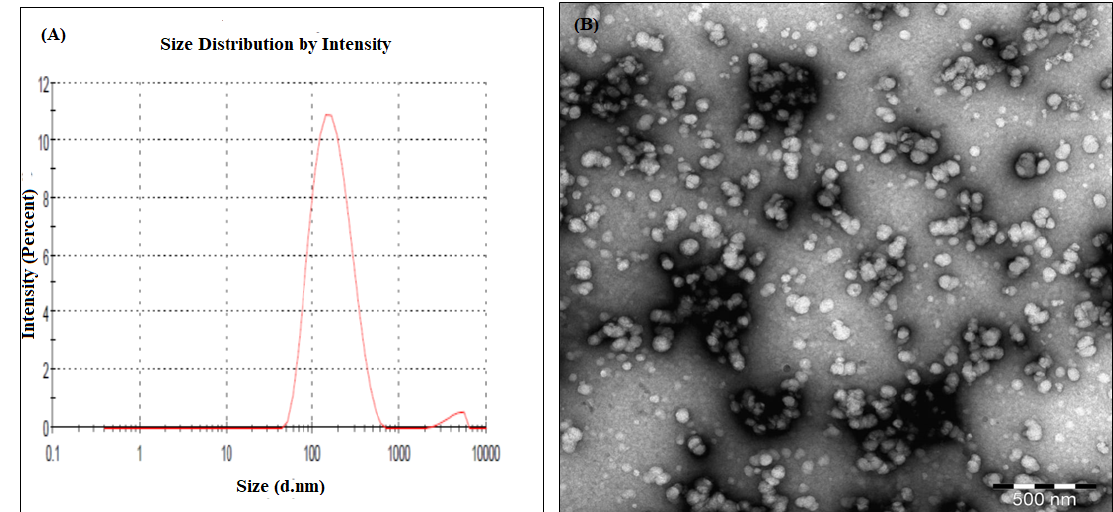
Figure 2. Particle size analysis using zetasizer ( A ) and TEM ( B ).